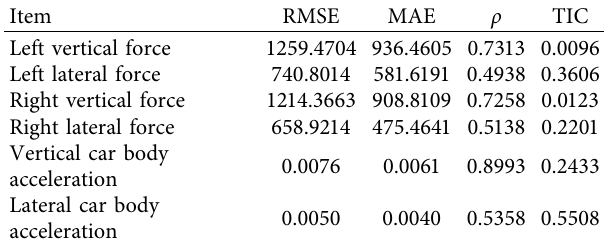
Table 4: Te accuracy index of various vehicle response